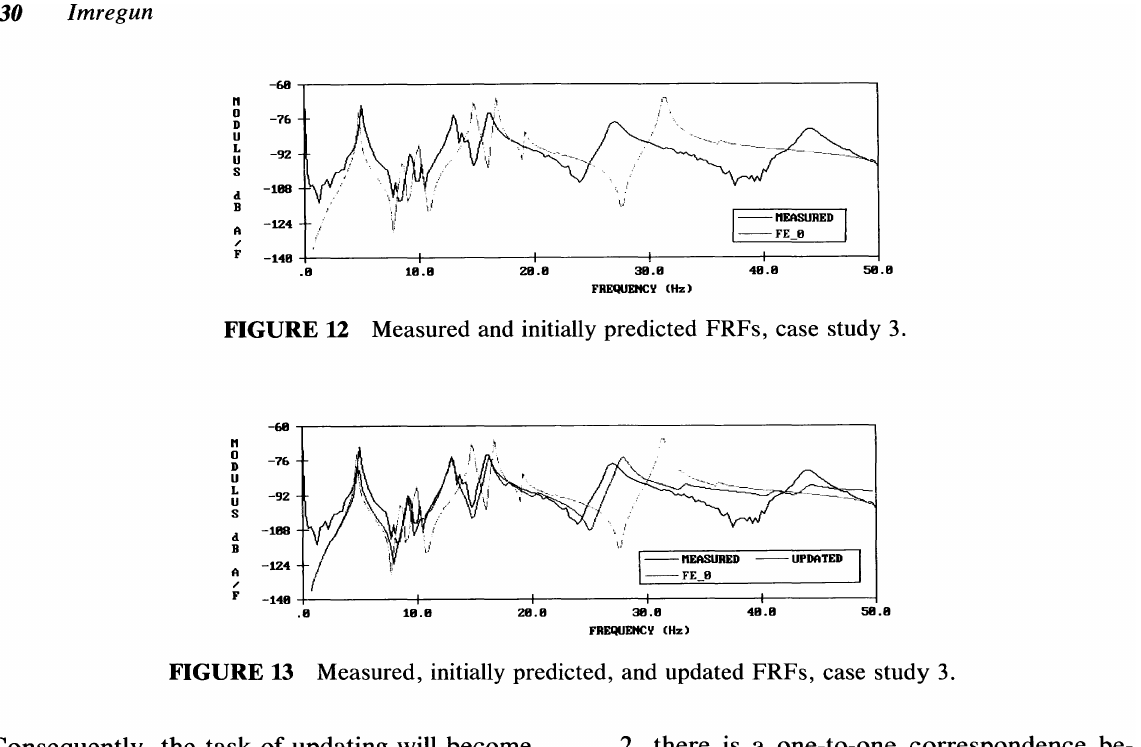
FIGURE 13 Measured, initially predicted, and updated FRFs, case study 3.